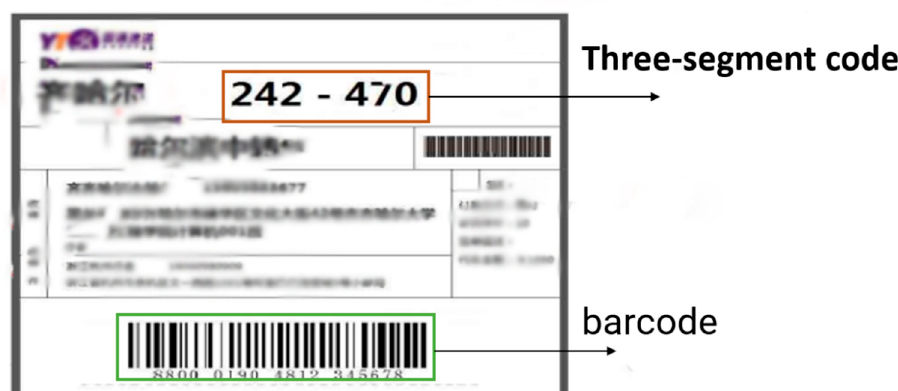
Figure 7. Courier sheet three-segment code style.